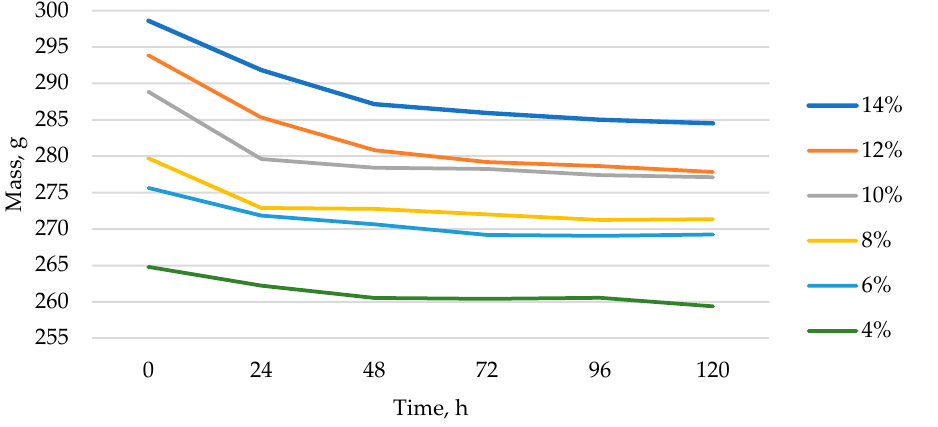
Figure 10. Changes of sample mass with binder 4–14%.